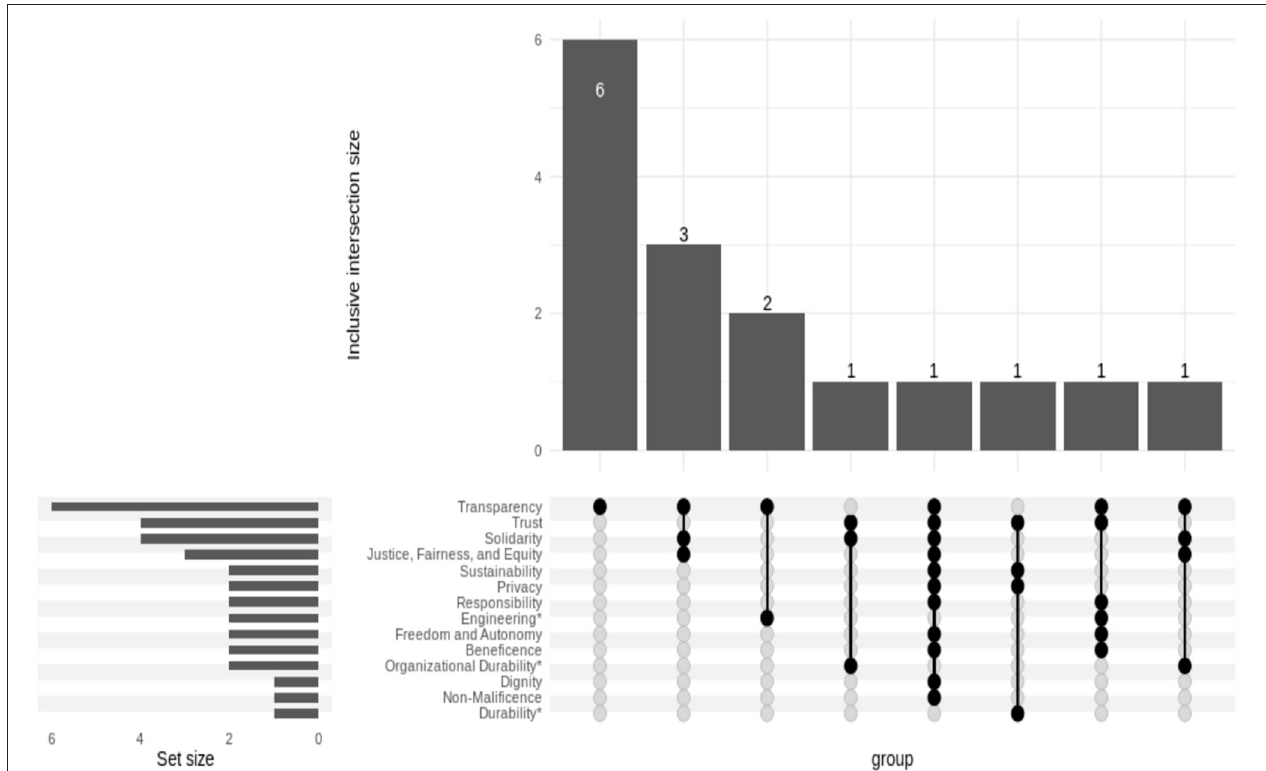
FIGURE 2 | Common core of values. *Denotes an extension to the core categorization developed in Jobin et al.